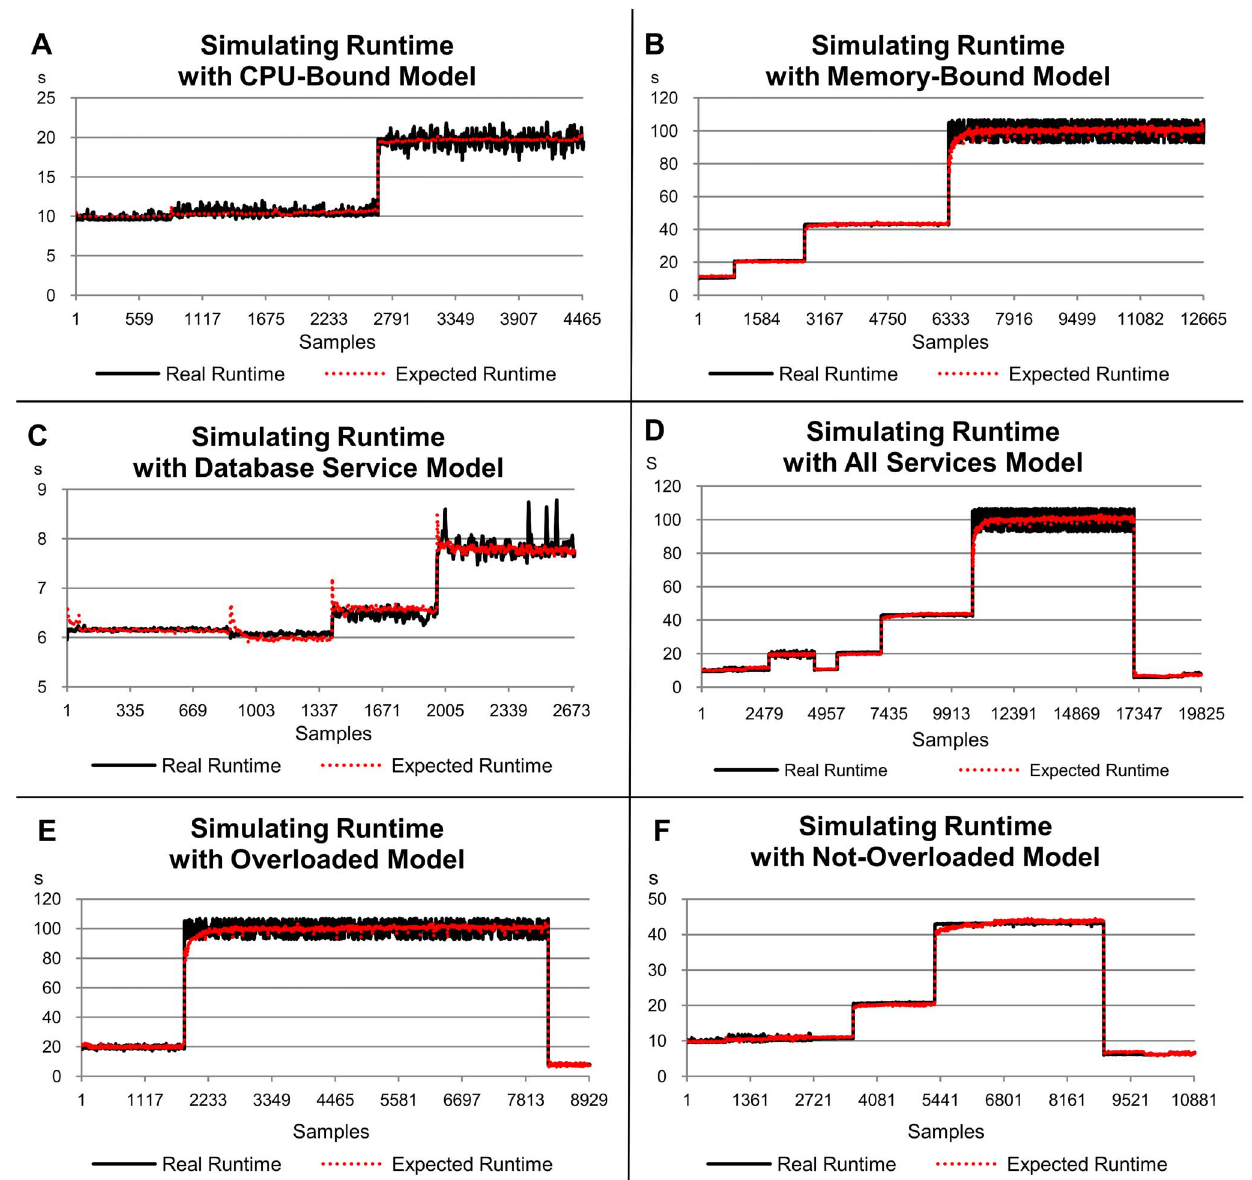
Figure 2. Graphs showing the relation between the predicted runtimes based on multiple linear models (used in the six scenarios) and the actual runtimes. The x-axis represents the samples collected every 10 s by Ganglia and JMX while the benchmarks were requesting services for the server.